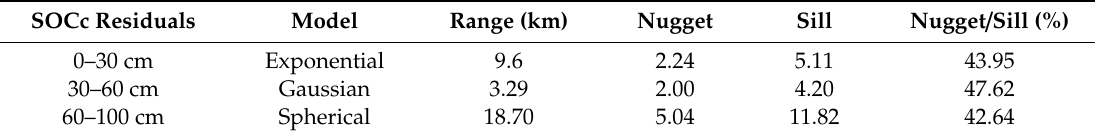
Table 4. Parameters for the isotropic semivariogram models for wetland SOCc residuals. SOCc Residuals Model Range (km)